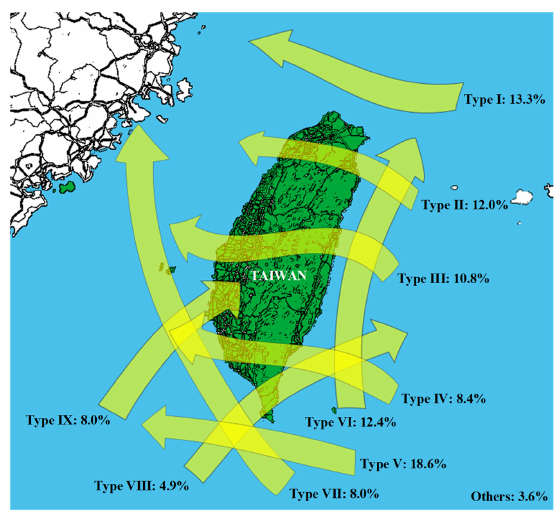
Figure 19. Historical typhoon tracks around Taiwan from 1897–2017.